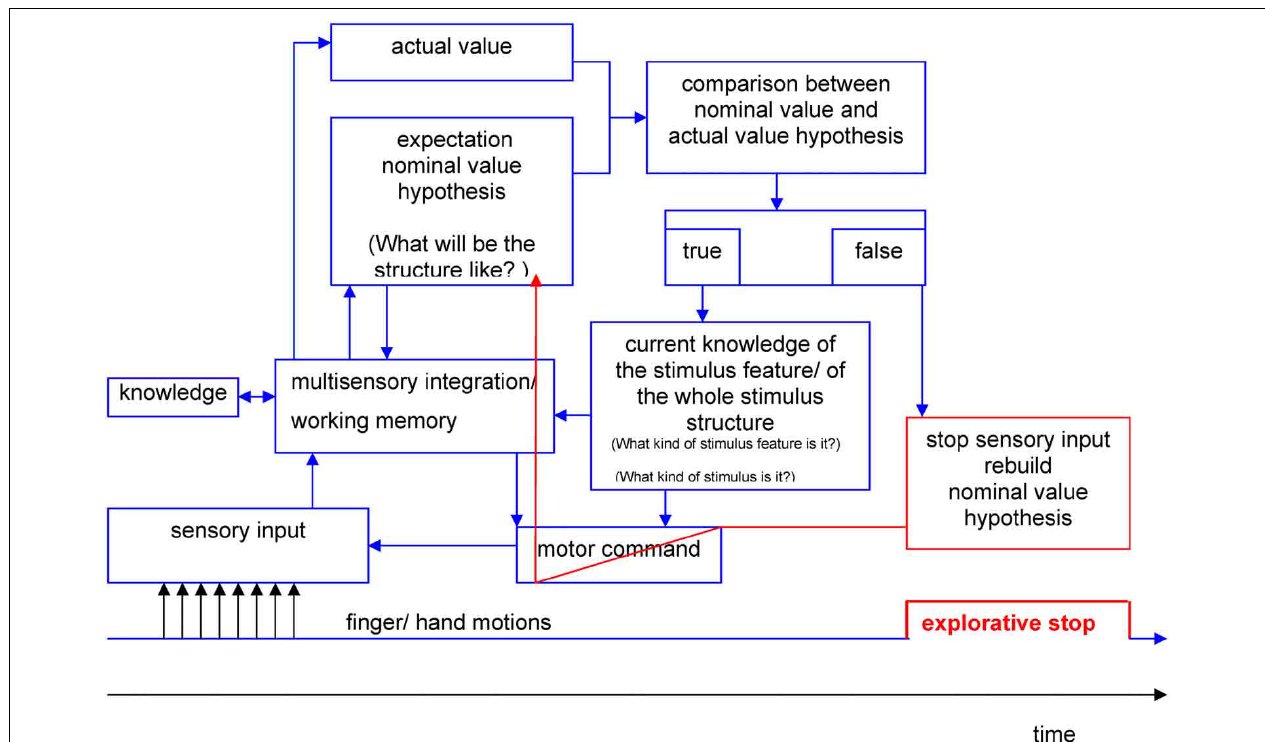
FIGURE 8 | Hypothesis-rebuild-model for explorative stops during human haptic perception (details see